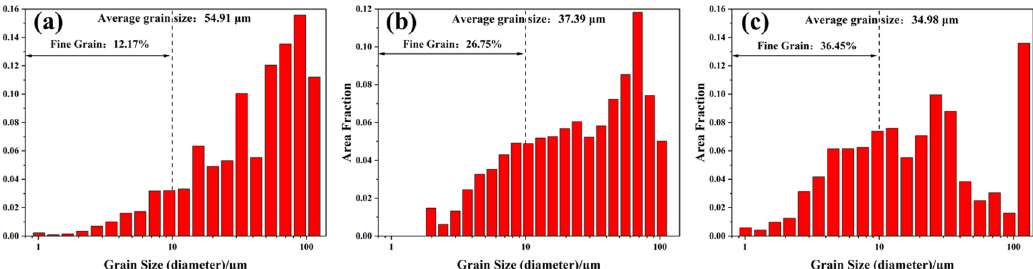
Figure 8. Statistical results of grain size on XY planes of Cu–Cr–Nb–Ti alloy samples manufactured by scanning speeds of ( a ) 500 mm/s (P 325 V 500 ), ( b ) 800 mm/s (P 325 V 800 ), and ( c ) 1100 mm/s (P 325 V 1100 ) (laser power of 325